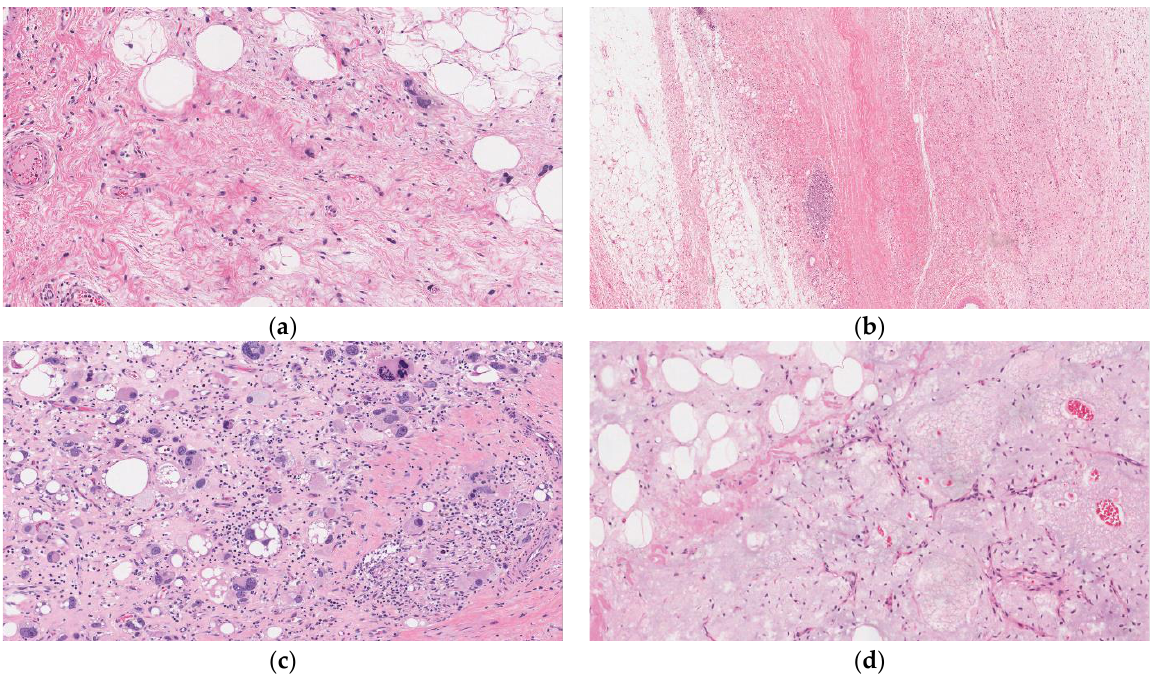
Figure 1. Liposarcoma subtypes. Photomicrographs from representative cases obtained at The Ottawa Hospital. Slides stained with Hematoxylin and Eosin (H&E) with corresponding magnifications as follows: Well-differentiated liposarcoma (WDLPS) with hyperchromatic and atypical nuclei within adipocytes and fibrous septa H&E 100 × ( a ) De-differentiated liposarcoma (DDLPS) with transition from lipomatous component to non-lipomatous solid component H&E 20 × ( b ) pleomorphic liposarcoma with pleomorphic multi-vacuolated lipoblasts H&E 100 × ( c ) myxoid liposarcoma H&E 100 × ( d ).